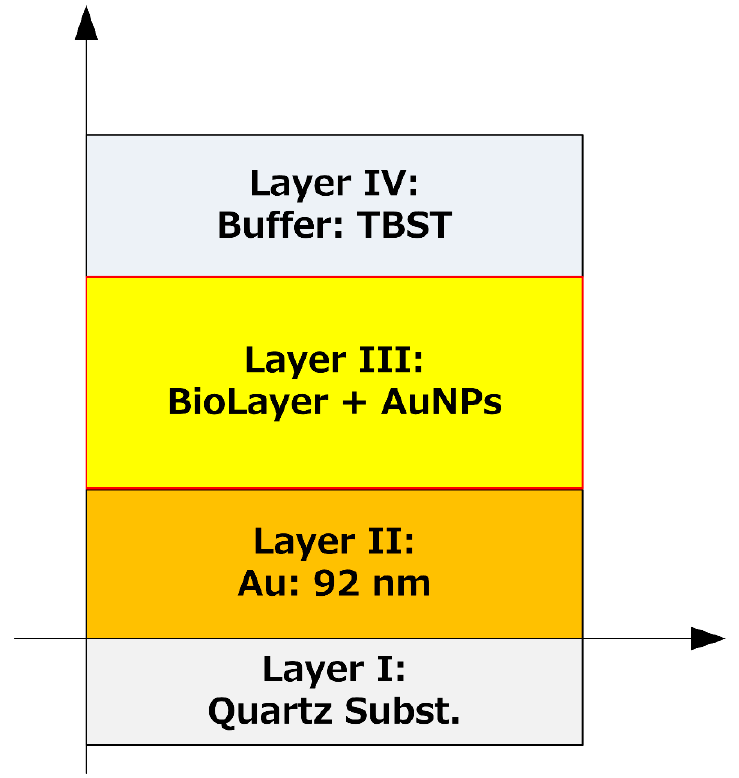
Figure 13. Calculated biosensor and biolayer structures.